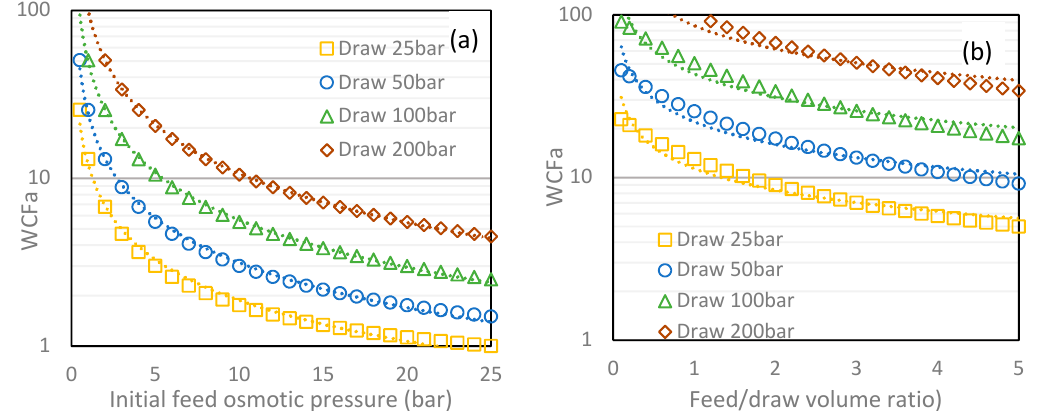
Figure 4. Modelling of WCF a as function of ( a ) draw solute concentration and initial feed osmotic pressure (feed draw ratio 1), ( b ) feed draw ratio and draw osmotic pressure for π F = 1 bar.